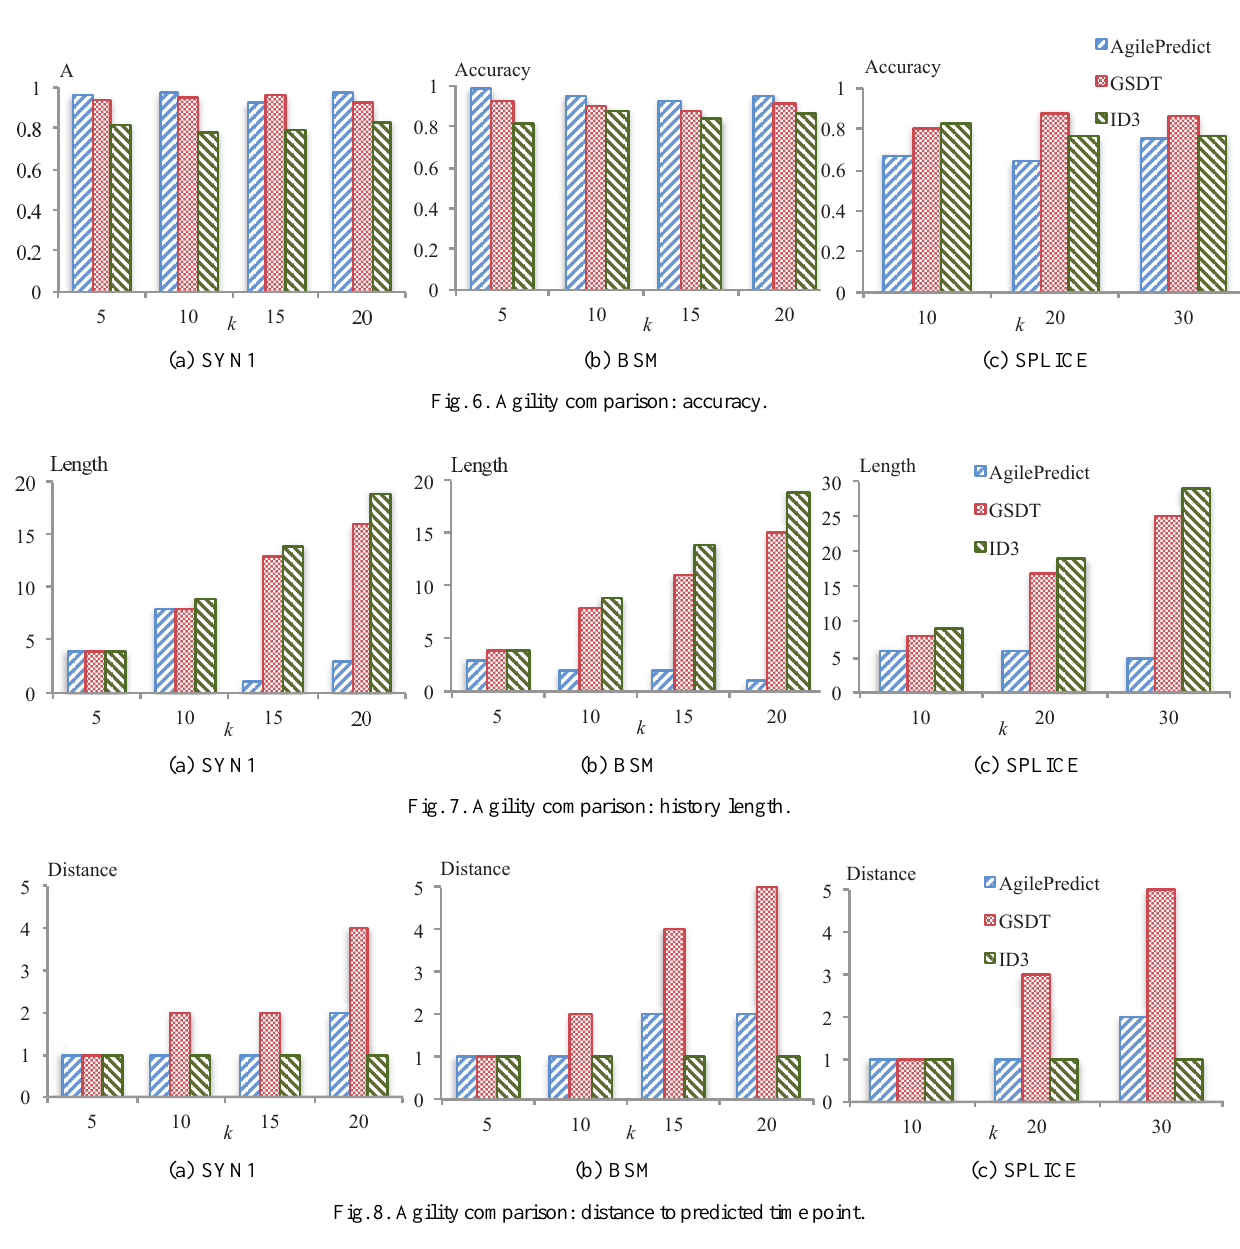
Fig. 8. Agility comparison: distance to predicted time